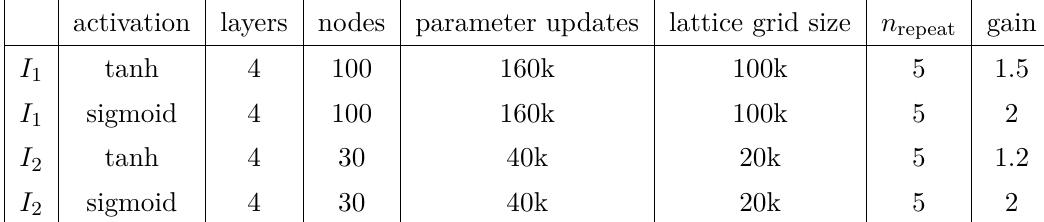
Table 1 . Network parameter for the results shown in this